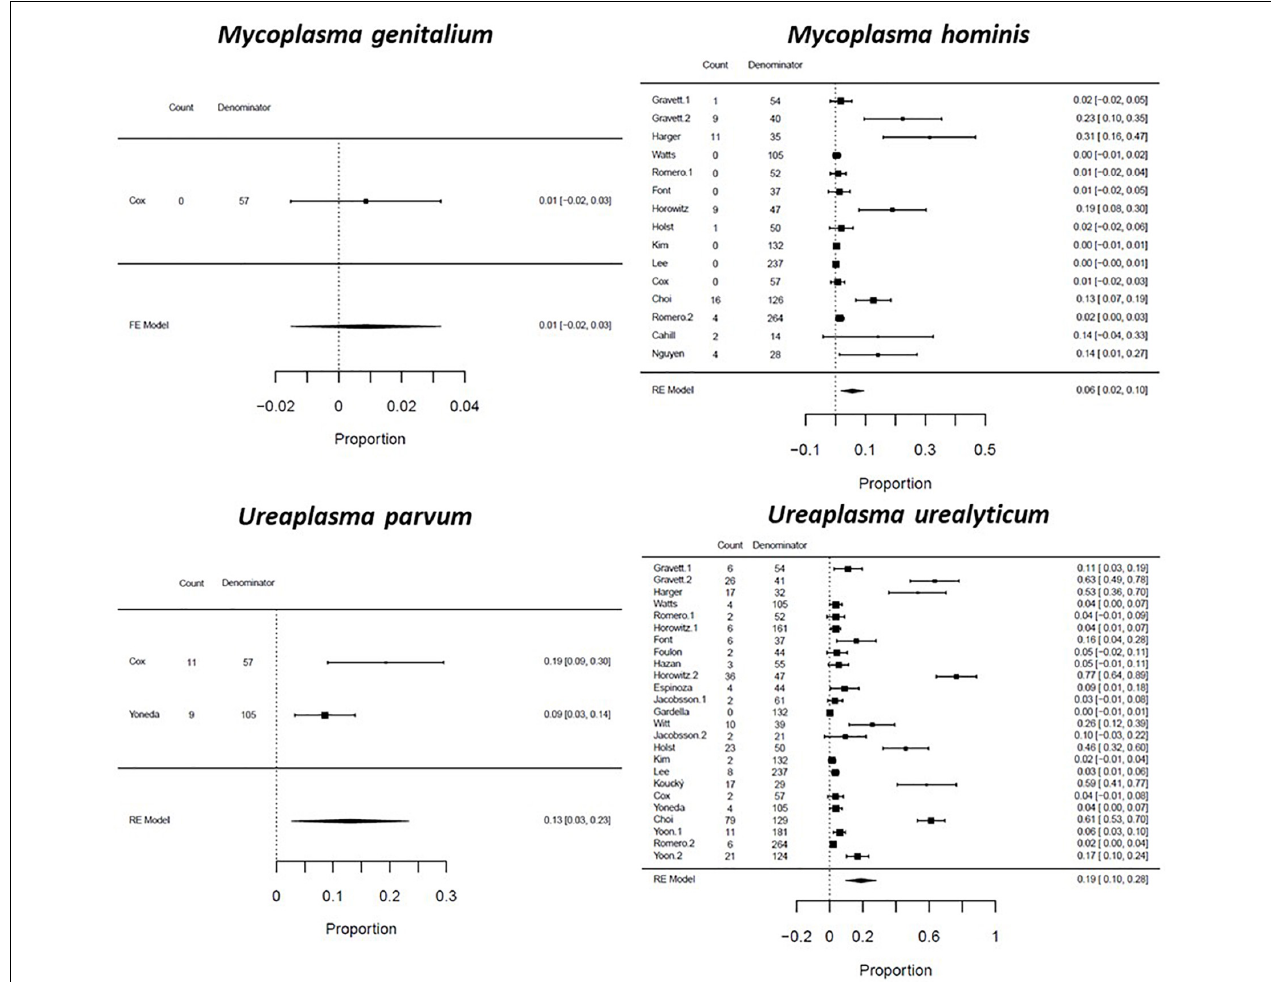
FIGURE 5 | Forest plot for the pooled proportion of genital Mycoplasma infection among spontaneous preterm labor